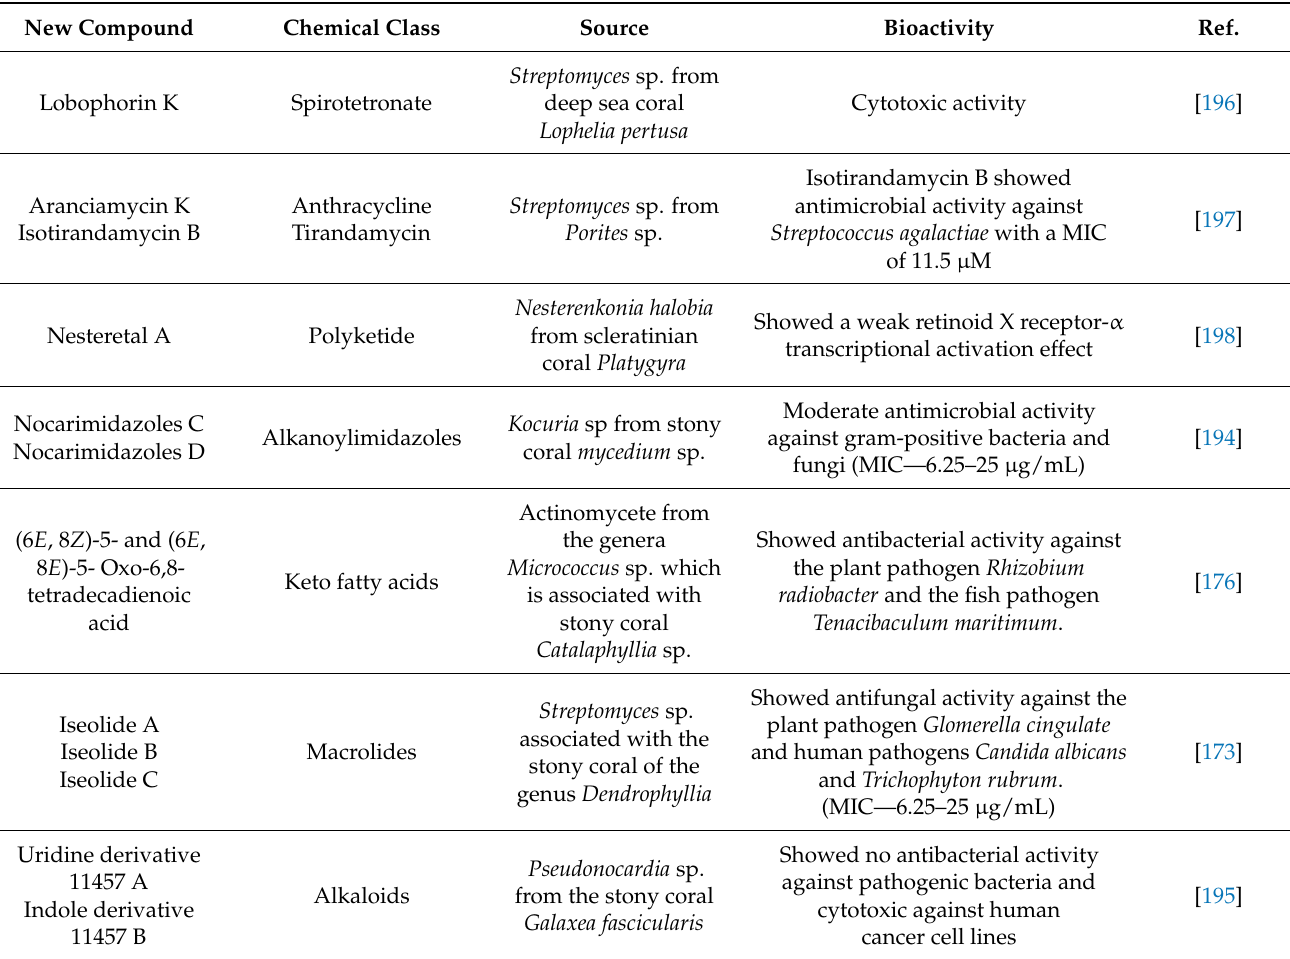
Table 3. New compounds of Actinobacteria from corals (order Scleractinia) reported between 2017 to